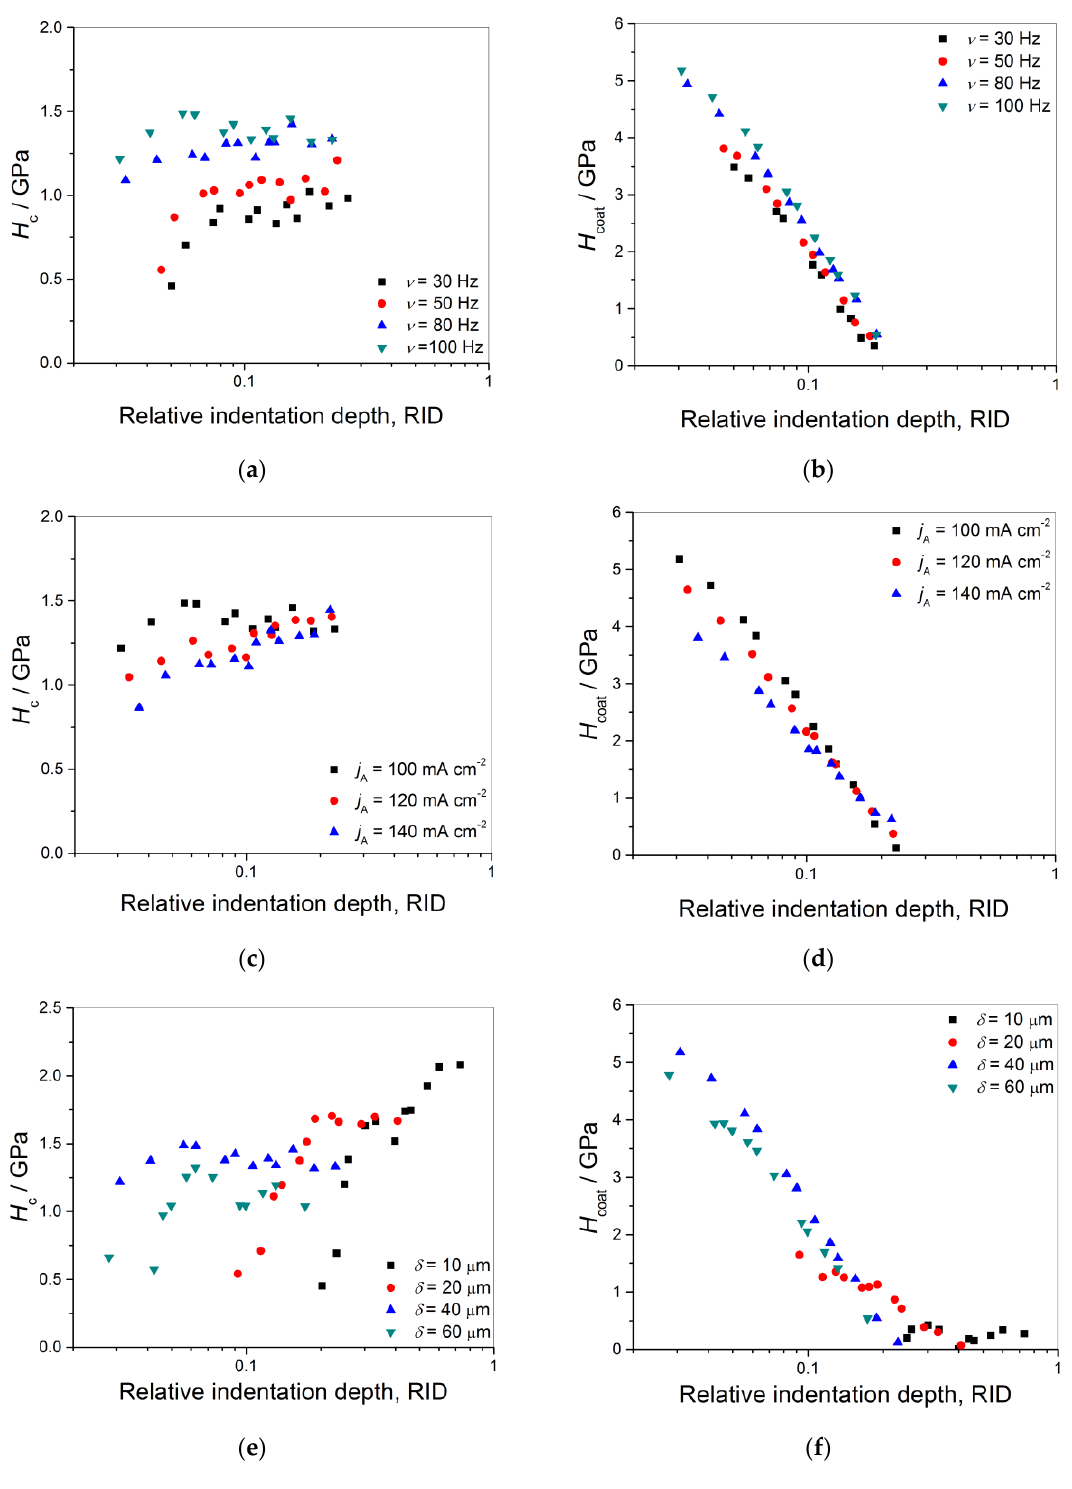
Figure 10. The hardness variation with relative indentation depth calculated according to the Chicot–Lesage composite hardness model: ( a , c , e ) composite systems ( H c ), and ( b , d , f ) the microhardness of Cu coatings ( H coat ): ( a , b ) ν : 30, 50, 80 and 100 Hz, ( c , d ) j A : 100, 120 and 140 mA · cm − 2 , ( e , f ) δ : 10, 20, 40 and 60 µ